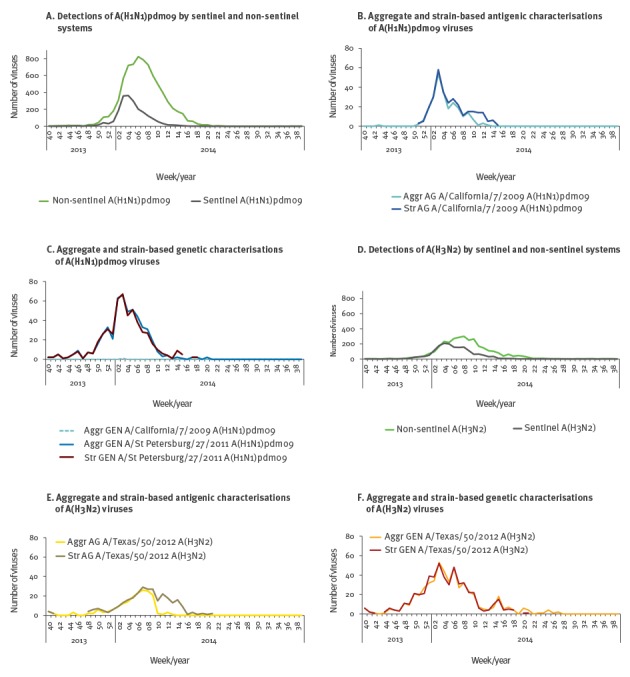
Detections and characterisations by influenza A virus subtype and surveillance system, by week of specimen collection, strain-based reporting of antigenic and genetic characterisation data, 11 European countries, influenza season 2013/14